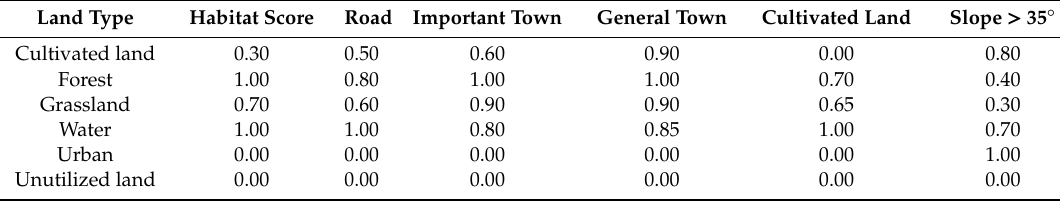
Table 4. Sensitivity of di ff erent land types to di ff erent threat